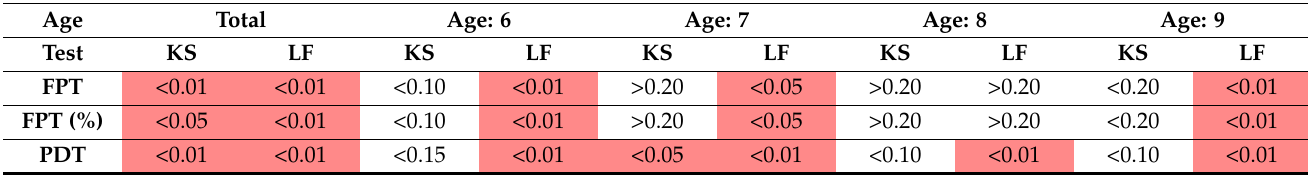
Table A2. Tests for normality to verify the distribution of data. Test value (p) below 0.05 (marked in red in the table) indicates rejection of the null hypothesis (H0) assuming a normal distribution (autors’ own